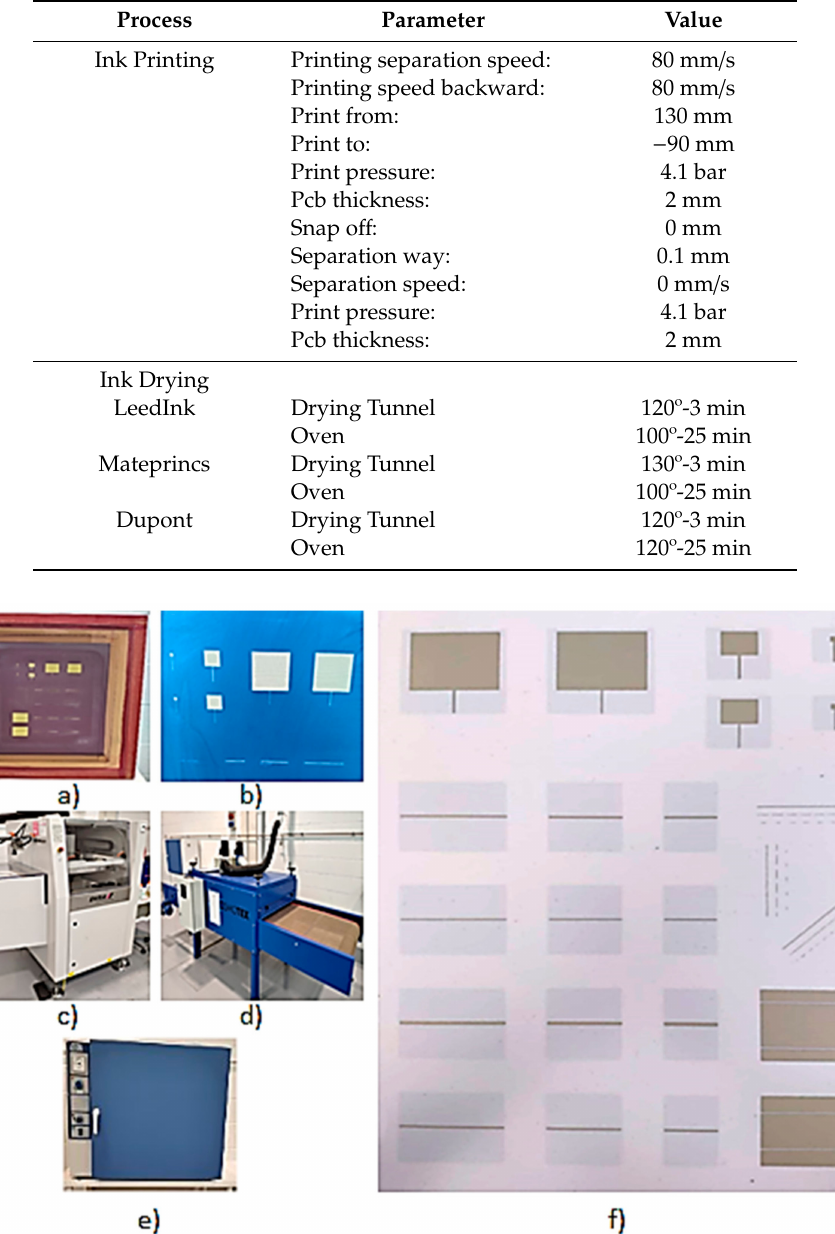
Figure 2. ( a ) Printing stencil, ( b ) detail of the implemented mask, ( c ) screen printer, ( d ) tunnel, ( e ) box oven, ( f ) printed sheet (top layer) as an output from the aforementioned screen-printing process. Multiple layouts can be placed within the sheet, for calibration and test purposes. The tested prototypes can be seen on the top right of the